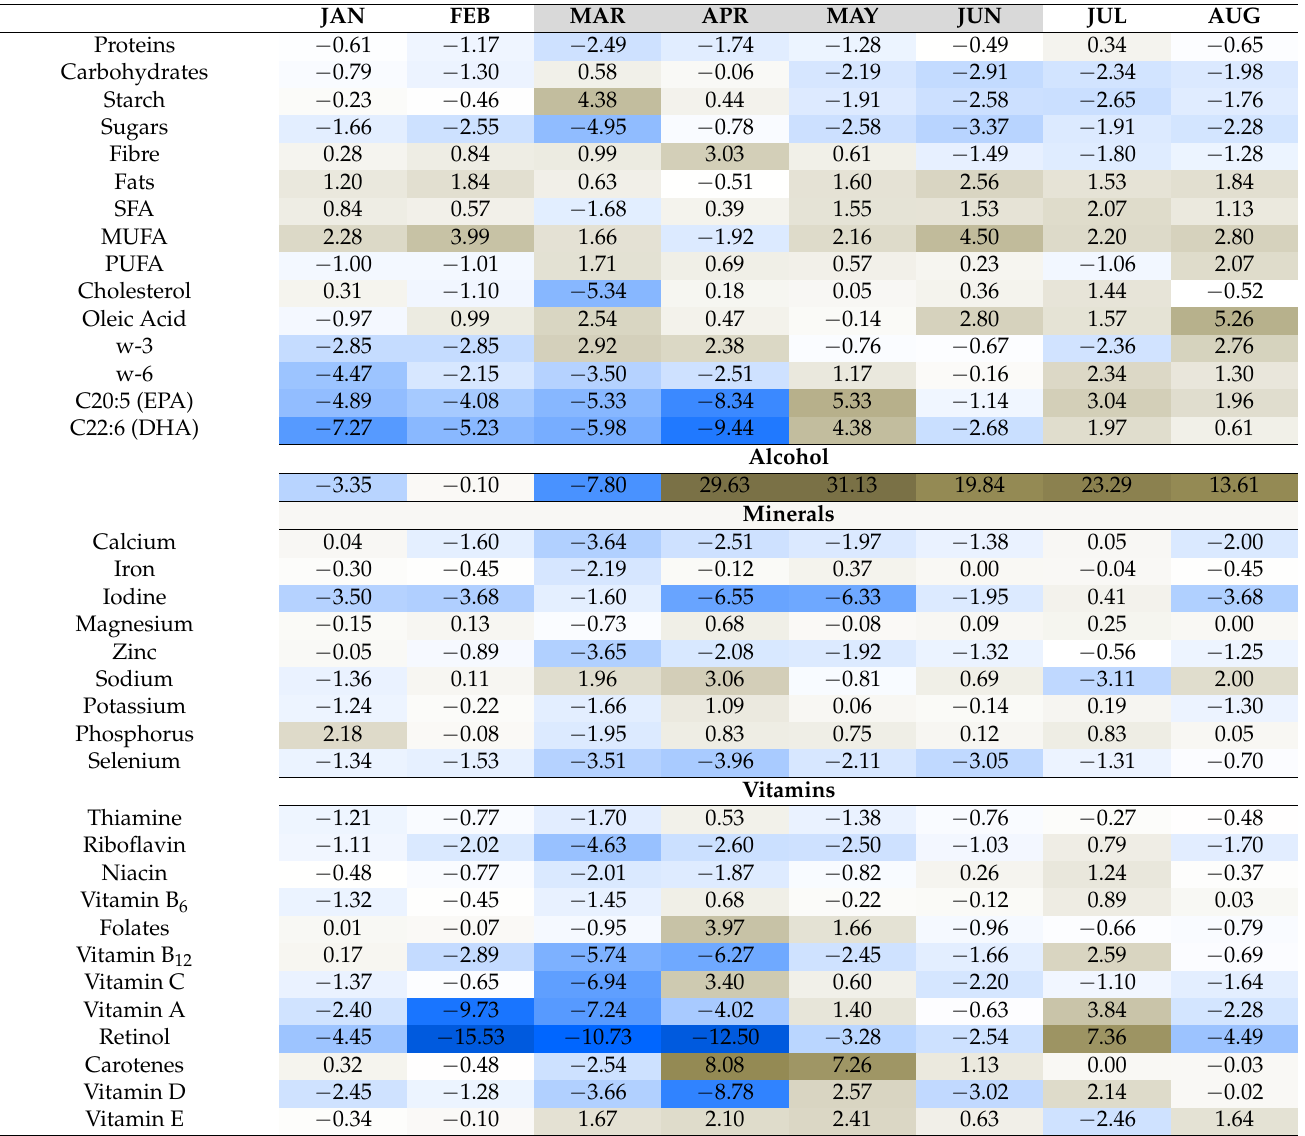
Table 4. Relative change in nutrient density (unit/1000 kcal) and alcohol (g/1000 kcal) estimated from food and beverages purchased in Spanish households in 2020 with respect to 2019 (%).